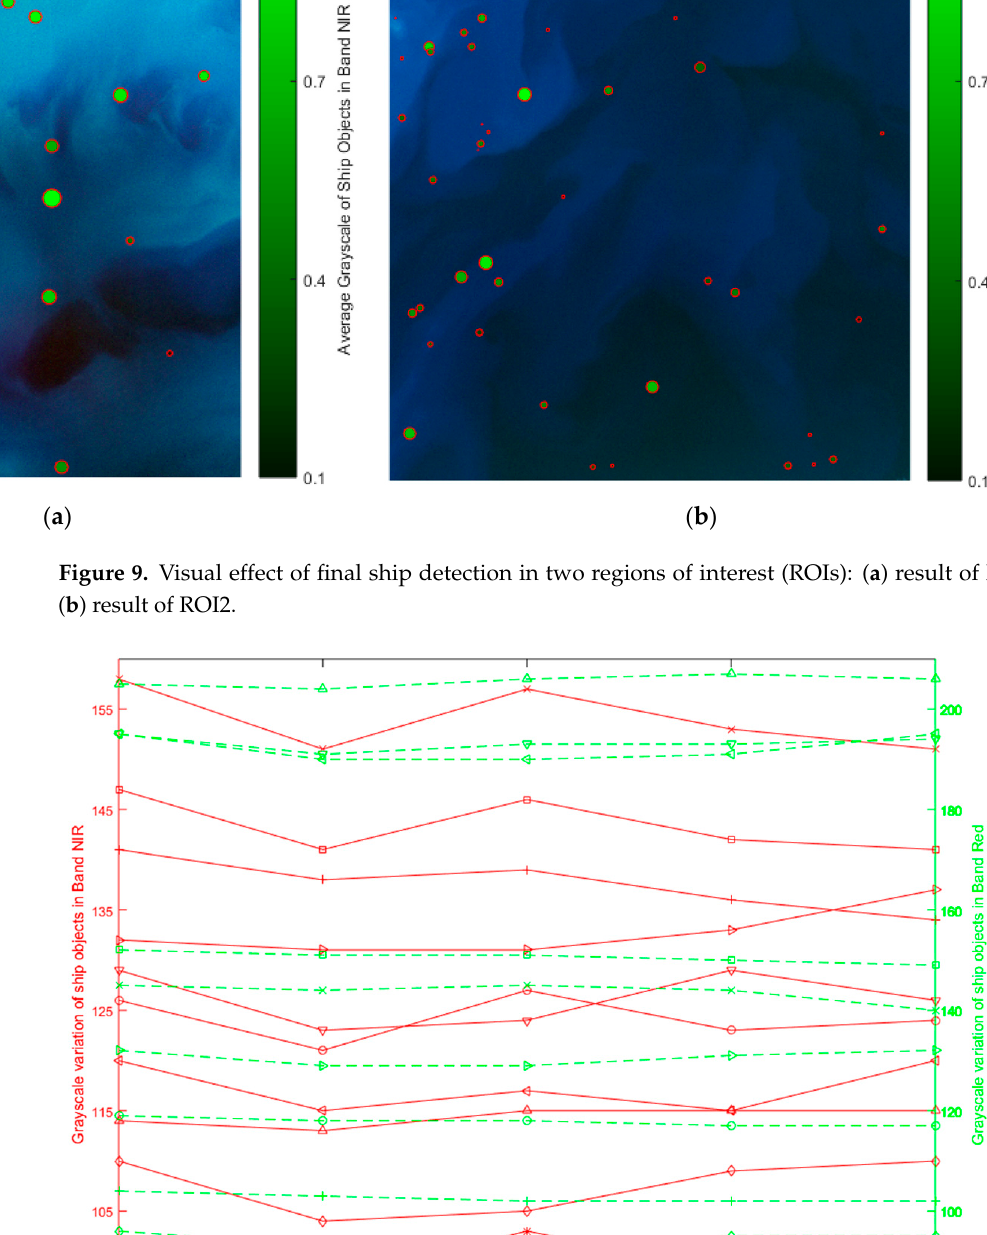
Figure 11. The size variations of 10 ships over multiple frames. Lines with di ff erent colors and marks denote di ff erent ships. Figure 12. The point pairs in the fi rst frame used for geometric correction. The blue lines connect- ing AIS points and GF-4 points denote the associations between point pairs.